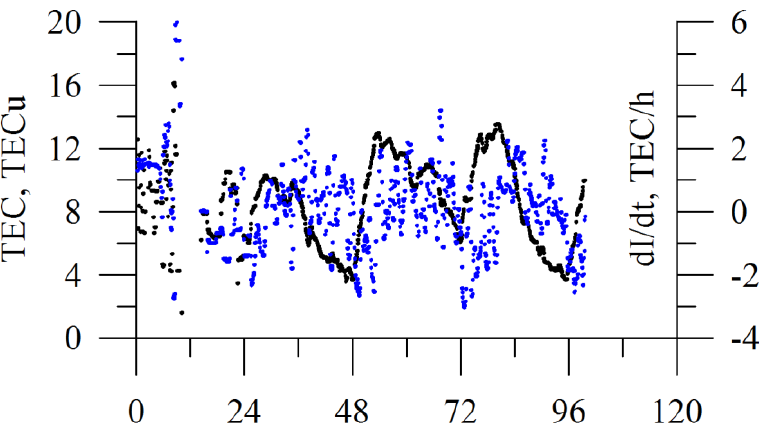
Figure 15. Dynamics of TEC and TEC time derivative.